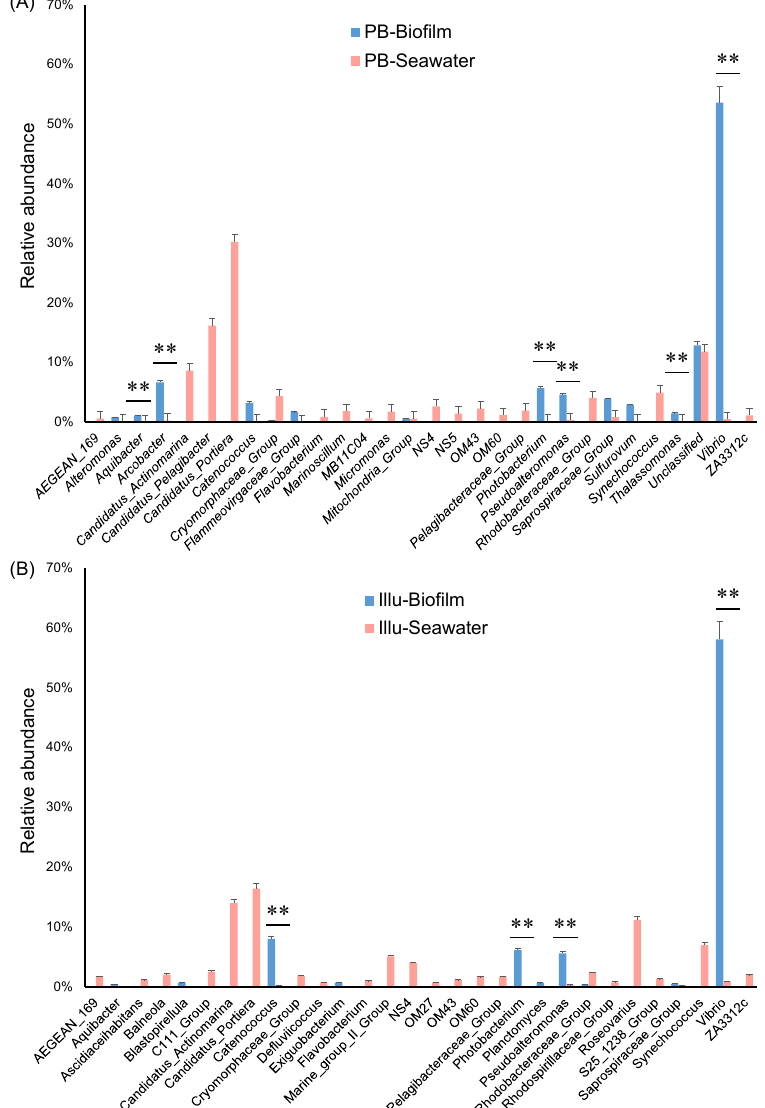
Figure 6. Statistical analysis of the 30 most abundant genera in biofilm and seawater samples. There were significant differences in genera between the biofilm and the seawater communities. ‘**’ represents a p -value < 0.01, calculated by two-tailed Student’s t -test. ( A ) Biofilm and seawater microbial communities by PacBio sequencing. ( B ) Biofilm and seawater microbial communities by Illumina sequencing.